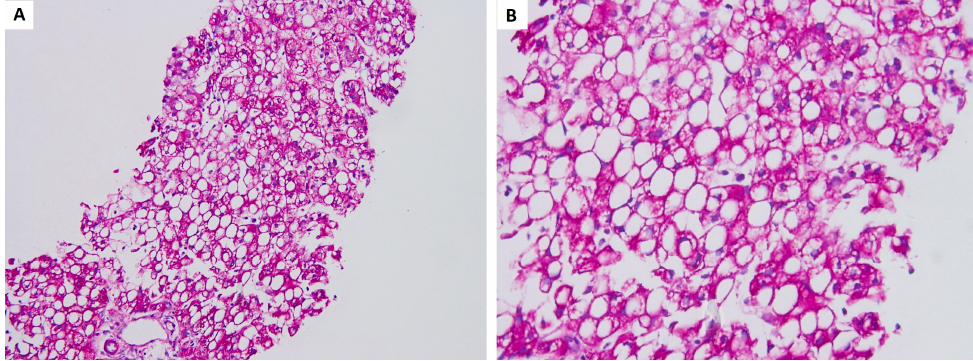
Figure 3. Periodic acid-Schiff staining showed negative result. ( A ) as observed under 200× and ( B ) as observed under 400×.